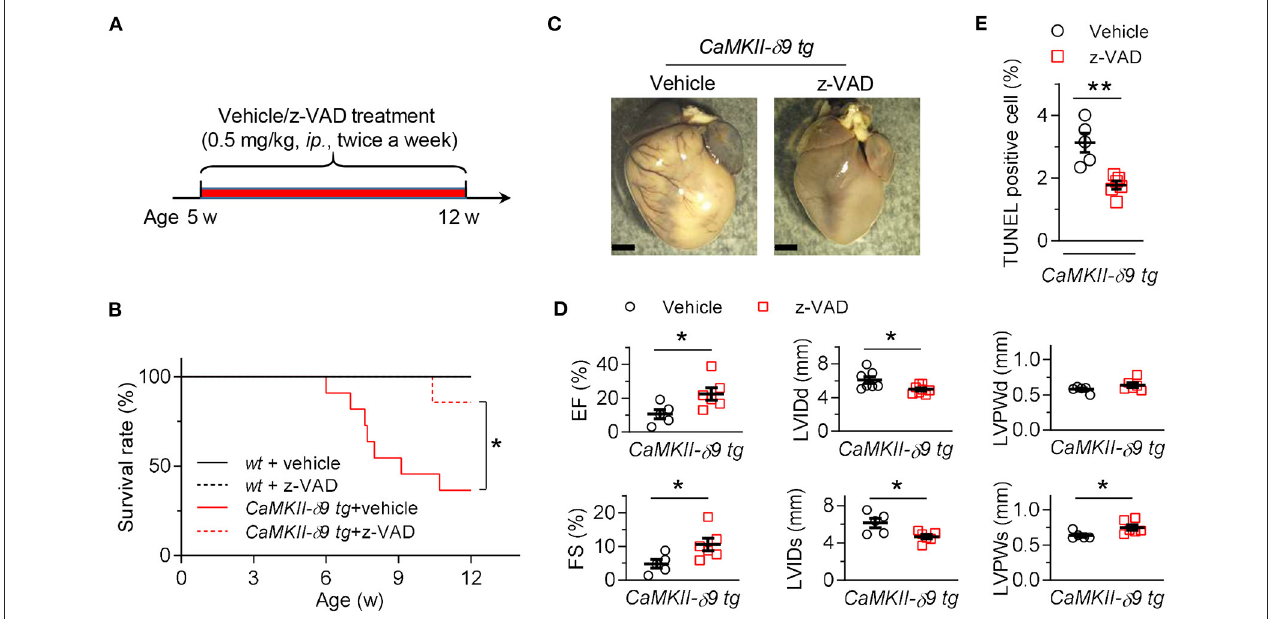
FIGURE 2 | Inhibition of cardiomyocyte death alleviates CaMKII- δ 9-induced cardiomyopathy and heart failure. (A) Experimental protocol for in vivo z-VAD treatment in CaMKII- δ 9 tg mice. The mice were treated with z-VAD (0.5 mg/kg, i.p. ) twice a week from 5 to 12 weeks of age. (B) Kaplan-Meier survival curves of wt and CaMKII- δ 9 tg mice with or without z-VAD treatment ( n = 6 for wt vehicle, n = 5 for wt z-VAD, n = 11 for CaMKII- δ 9 tg vehicle, n = 7 for CaMKII- δ 9 tg z-VAD). (C–E) Gross morphology of the hearts (C) , statistical data of the left ventricle echocardiography (D) , and statistical data of TUNEL staining of the hearts (E) from CaMKII- δ 9 tg mice with or without z-VAD treatment. Scale bar, 2mm ( n = 5 for vehicle, n = 6 for z-VAD). Data are mean ± S.E.M. NS, not significant; * P < 0.05, ** P < 0.01; log-rank (Mantel-Cox) test (B) , or Student’s t -test (D,E)